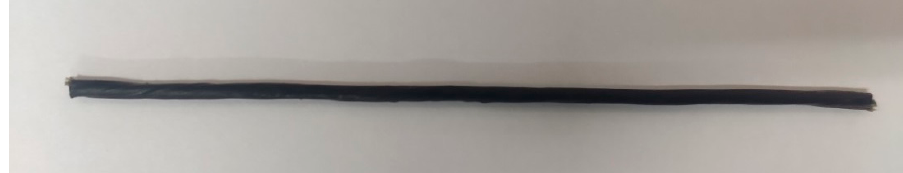
Figure 2. Photograph of the final product.